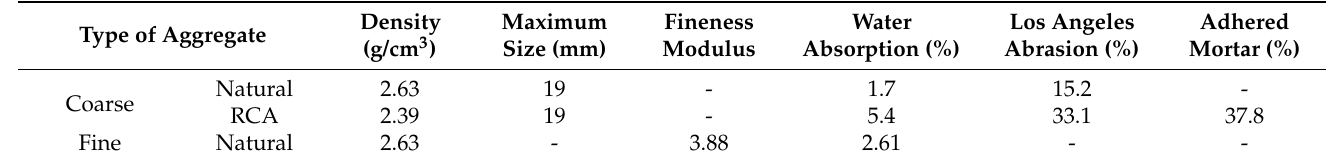
Table 3. Properties of RCA and natural aggregates.